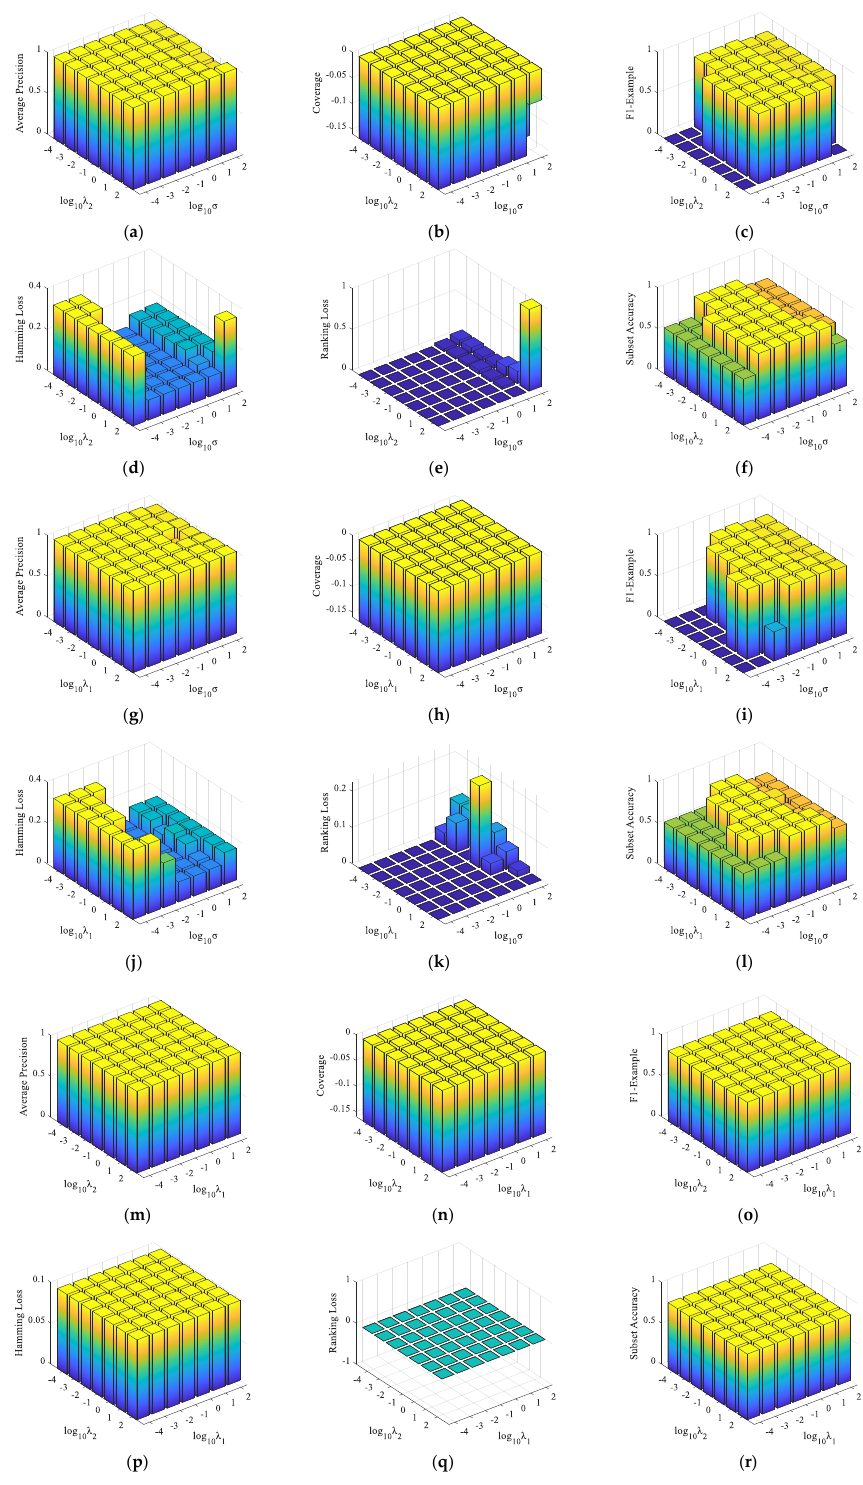
Figure 4. Sensitivity analysis of the hyperparameters of the model on the steelmaking dataset. ( a − f ) The sensitivity results of each evaluation with λ 1 fixed. ( g − l ) The sensitivity results of each evaluation with λ 2 fixed. ( m − r ) The sensitivity results of each evaluation with σ fixed.